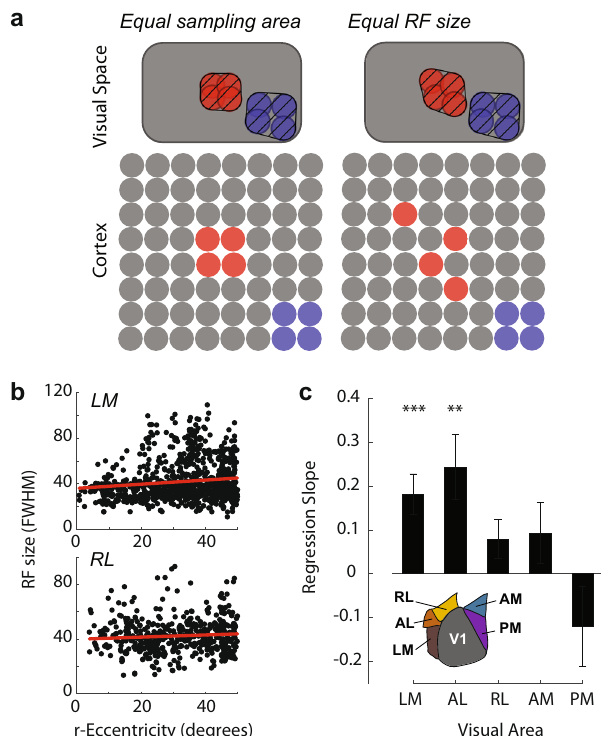
Fig. 6 Receptive fi elds in three higher visual areas are larger at greater eccentricities. a If neurons at all retinotopic positions in higher visual areas sample homogeneously from equal-sized regions of V1 (left panel), then neurons sampling from the foceal representation (red cells) will have smaller receptive fi elds (red cross-hatched region) than cells sampling from more scattered representations in the periphery (blue cells). Alternatively, neurons at different retinotopic positions in higher areas may use different V1 sampling strategies (right panel), which could counteract the reduced scatter at the focea to equalize RF size across eccentricities (compare the red vs blue cross-hatched region). b The relationship between r-eccentricity and single-cell RF size in LM ( n = 959 cells) and RL ( n = 505 cells) measured using two-photon imaging. c RF size increased with eccentricity in LM and AL. Asterisks indicate regression slopes that were signi fi cantly greater than zero: ** p < 0.01, *** p < 0.001 (Linear regression, H0: β = 0,